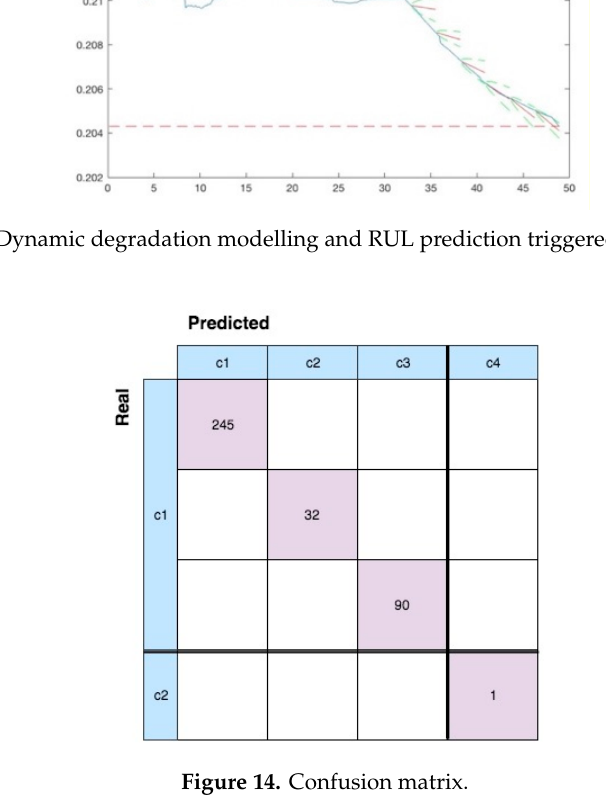
Figure 14. Confusion matrix.